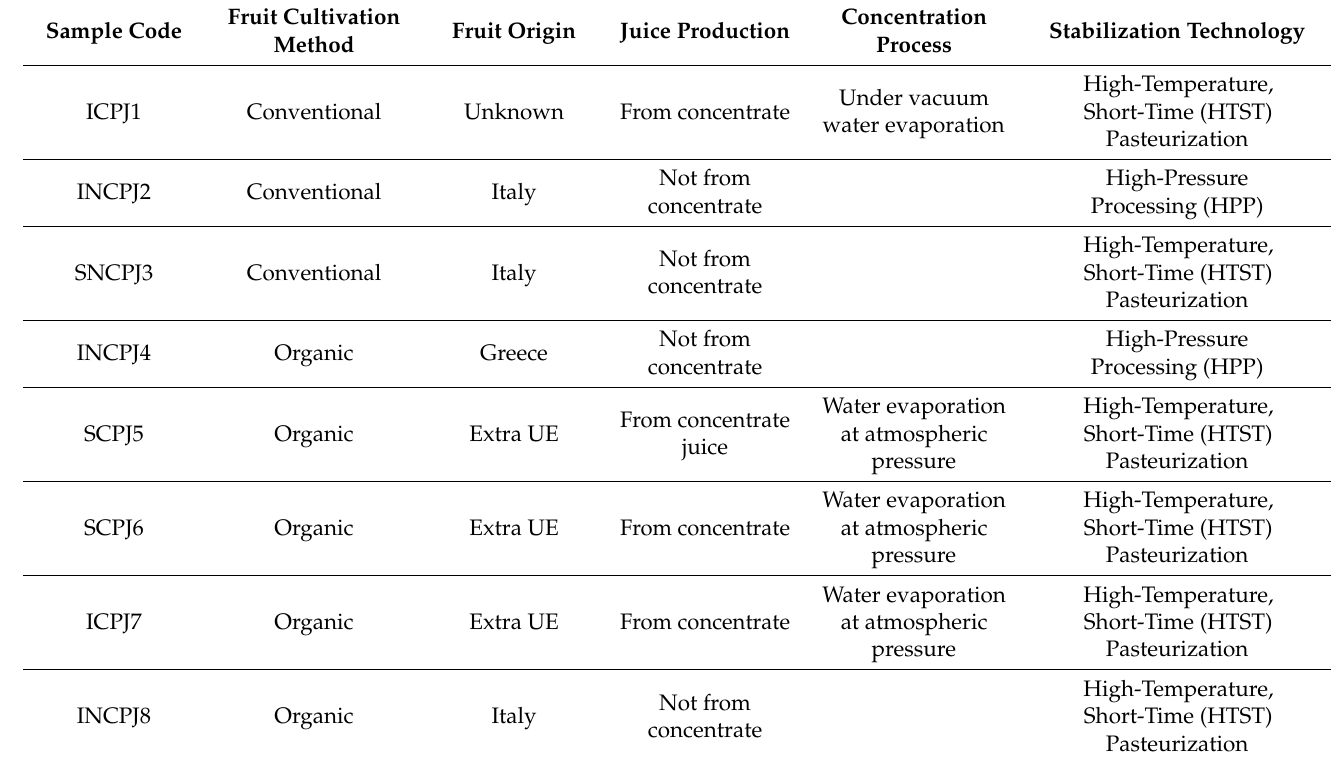
Table 1. Fruit origin, cultivation method, and technological aspects of the eight commercial PJs. Sample